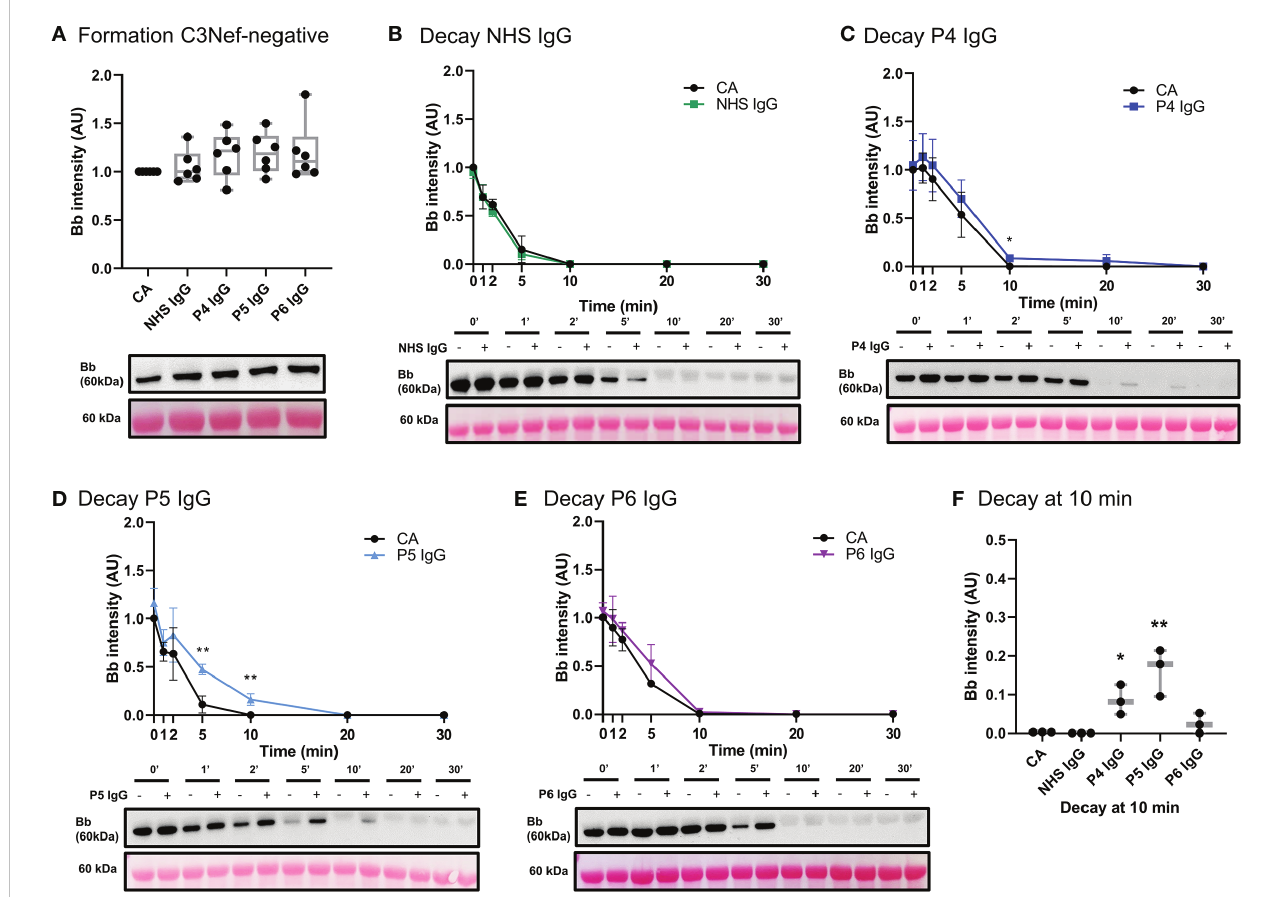
FIGURE 8 IgG from C3Nef- C3G patients do not promote C3 convertase formation but can increase its stability. (A) Western blot analysis of CA formed alone, or in presence of NHS, P4, P5 or P6 IgG. IgG from C3Nef-negative C3G patients does not affect C3bBb formation. Results were normalized to CA and presented as relative protein expression. Box plots show median, 1 st and 3 rd quartile ranges, and the individual data points of six independent experiments. Signi fi cance calculated for NHS IgG. (B) Western blot analysis showing C3 convertase formed alone (CA) or in presence of NHS IgG, then decayed for up to 30 min. NHS IgG do not stabilize C3 convertase (NHS IgG t 1/2 = 3 min , CA t 1/2 = 3.36 min ). (C – E) Western blot analyses shows C3 convertase formed alone ( CA) or in presence of IgG derived from C3Nef- patients, then decayed for up to 30 min. (C) P4 IgG increases C3bBb half-life 1.3-fold (P4 t 1/2 = 7 min , CA t 1/2 = 5.5 min ). (D) P5 IgG increases C3bBb half-life 1.7-fold (P5 t 1/2 = 5.5 min , CA t 1/2 = 3.3 min ). (E) P6 IgG increases C3bBb half- life 1.2-fold (P6 t 1/2 = 5.6 min CA t 1/2 = 4.6 min ). Mean±SD of three independent experiments. Statistical signi fi cance shown for comparisons between CA/ Patient IgG at the same timepoint. (F) Composite box plots showing C3 convertase stabilization by IgG from C3Nef-negative patients (P4, P5) after 10 min of decay in buffer. For all decay experiments, results were normalized to CA at 0 min and presented as relative protein expression. Ponceau S Staining was used as a measure of total protein load. Box plots show median, and the individual data points of three independent experiments. Signi fi cance calculated for NHS IgG at 10 min. * P ≤ 0.05, ** P ≤ 0.01, *** P ≤ 0.001, **** P ≤